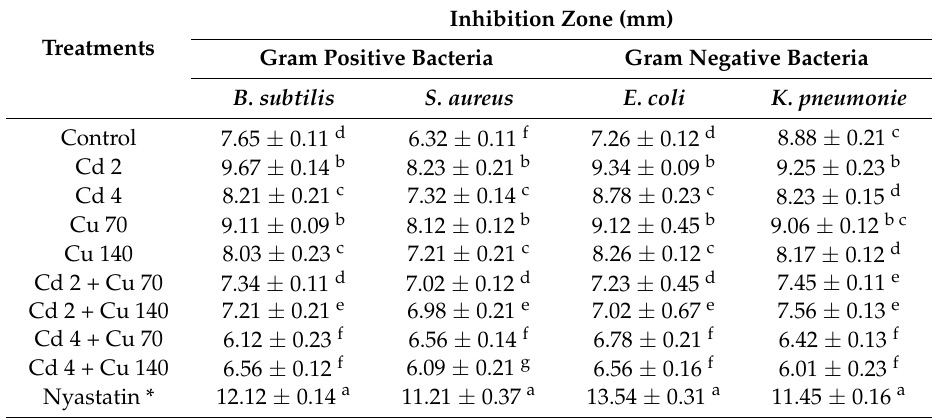
Table 5. Antimicrobial activity of Gynura procumbens leaves crude extracts of different cadmium and copper treatments based on disc diffusion